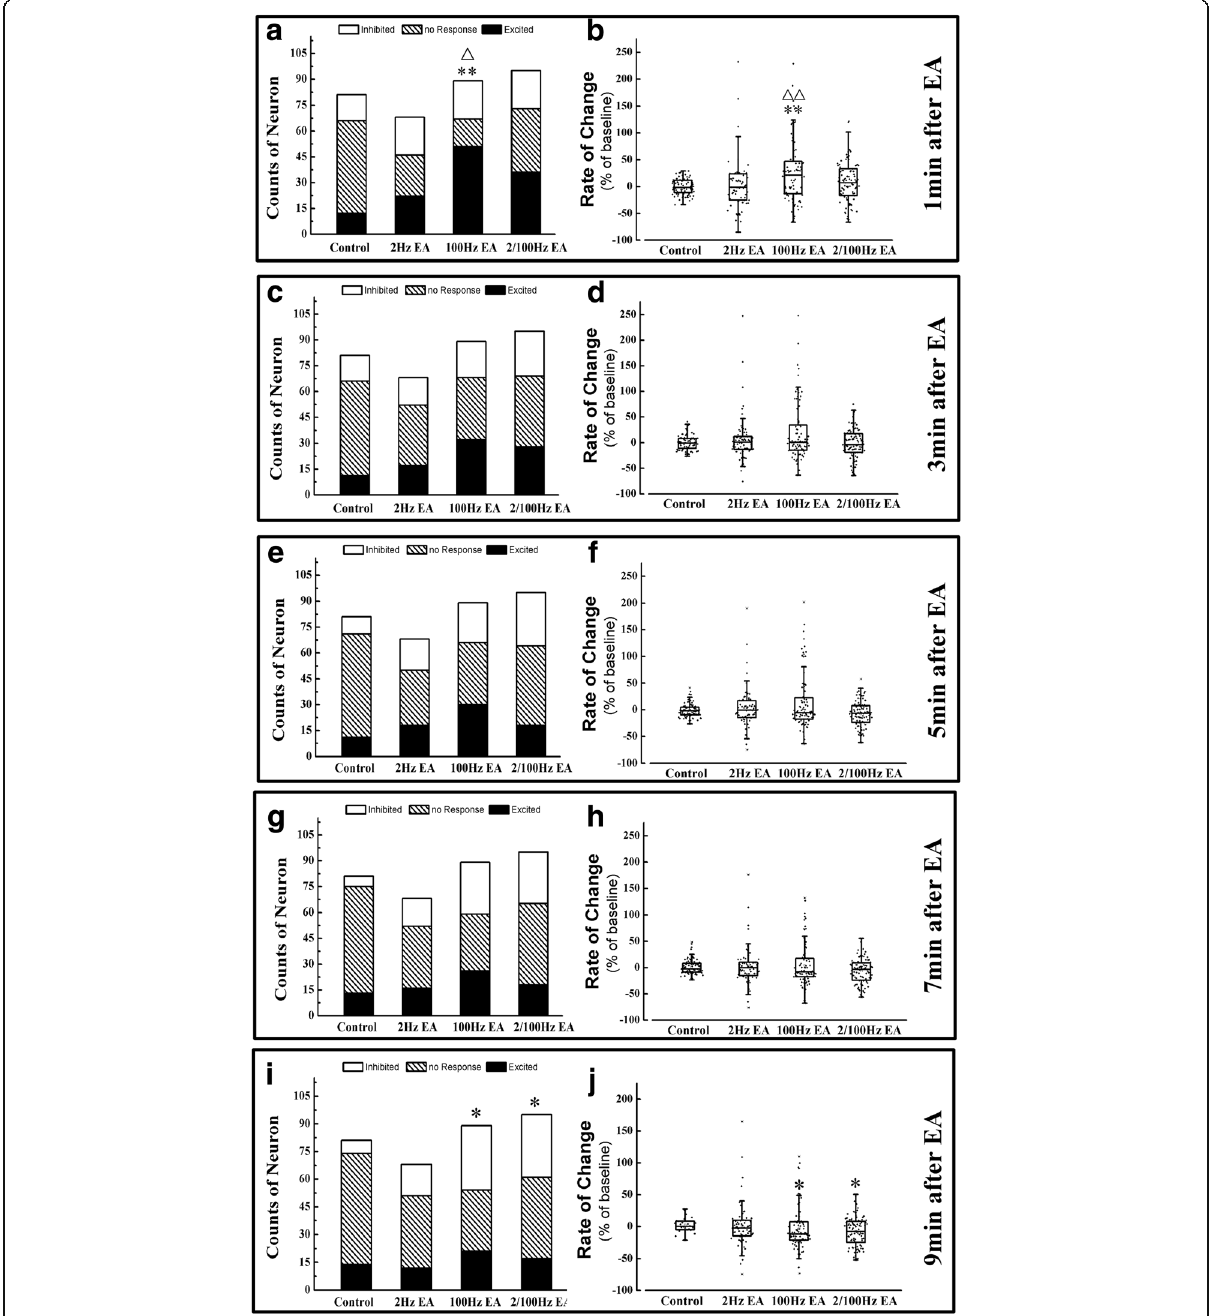
Fig. 2 The distribution of three types of neurons and the rate of change for spike frequency change rates in NTS after EA simulated at ST 25. The population of three types of neuron in NTS of four groups at 1 min ( a ), 3 min ( c ), 5 min ( e ), 7 min ( g ) and 9 min ( i ) after EA stimulated at ST 25. And the the rate of change of spike frequency for NTS neurons in four groups at 1 min ( b ), 3 min ( d ), 5 min ( f ), 7 min ( h ) and 9 min ( j ) after EA stimulated at ST 25. Results of the number of three types of neurons are real numbers and the rates of change of spike frequency are mean, quartile and standard deviation. n = 5. * P < 0.05, ** P < 0.01 versus control group, △ P < 0.05, △△ P < 0.01 versus model